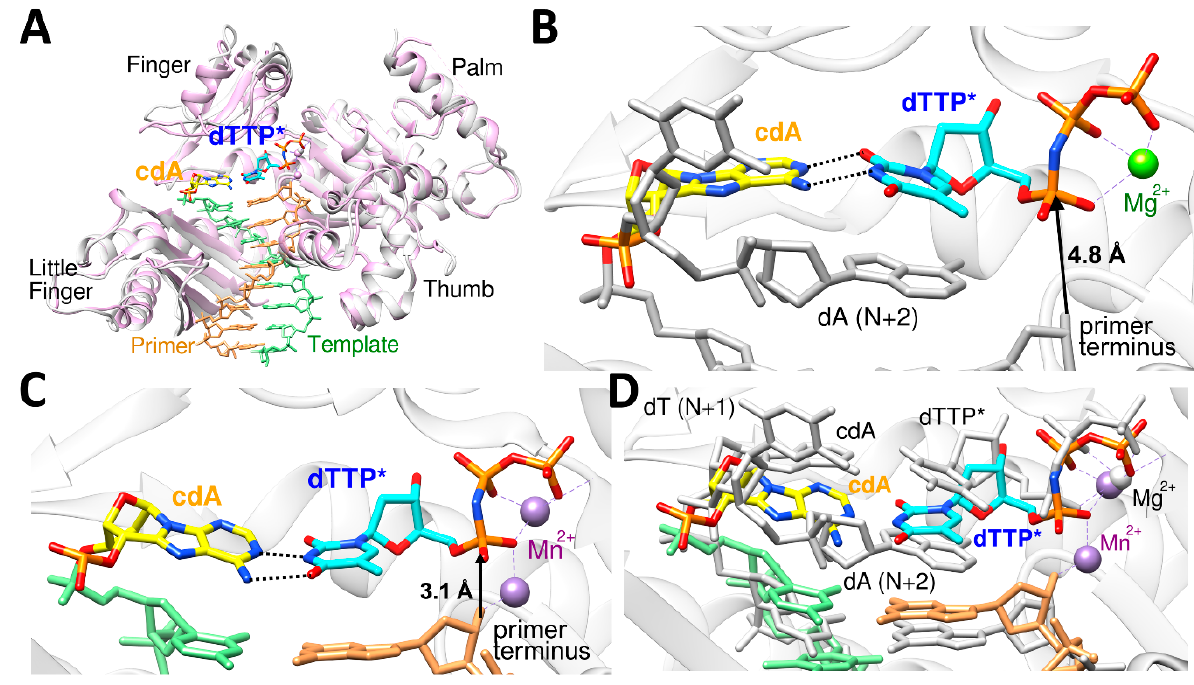
Figure 2. The overall structure and the structural comparison of cdA bypass by pol η with Mg 2+ (PDB ID: 6M7U) and Mn 2+ (PDB ID: 6M7O). ( A ) The overall structure of pol η with cdA containing DNA and the incoming dTTP* in the presence of Mn 2+ (plum ribbon) superposed with Mg 2+ containing pol η -cdA structure (gray). ( B ) The non-optimal interaction between cdA and the incoming dTTP* in the presence of Mg 2+ . There is just one Mg 2+ catalytic metal with long distance between the primer terminus and P α of dTTP*. ( C ) The near-optimal interaction between cdA and the incoming dTTP* in the presence of Mn 2+ . There are two catalytic Mn 2+ metals with close proximity between the primer terminus and P α of dTTP*. ( D ) The superposed close-up structures of pol η -cdA:Mn 2+ (multi color) and pol η -cdA:Mg 2+ (gray). Table 3. Kinetic parameters for nucleotide incorporation opposite N7-alkylG and dG by pol η [14,40].